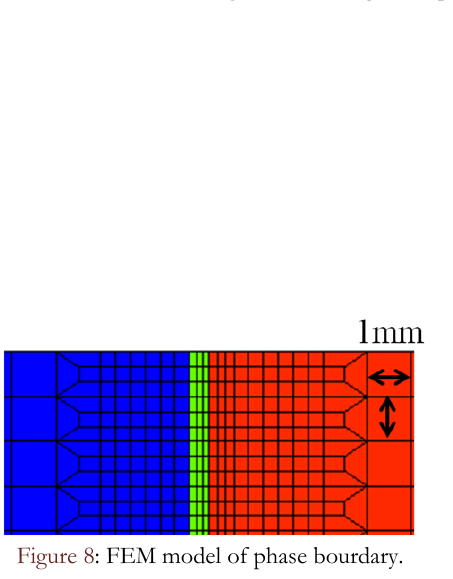
Figure 7: Crack growth path in experiment and numeircal simulation.